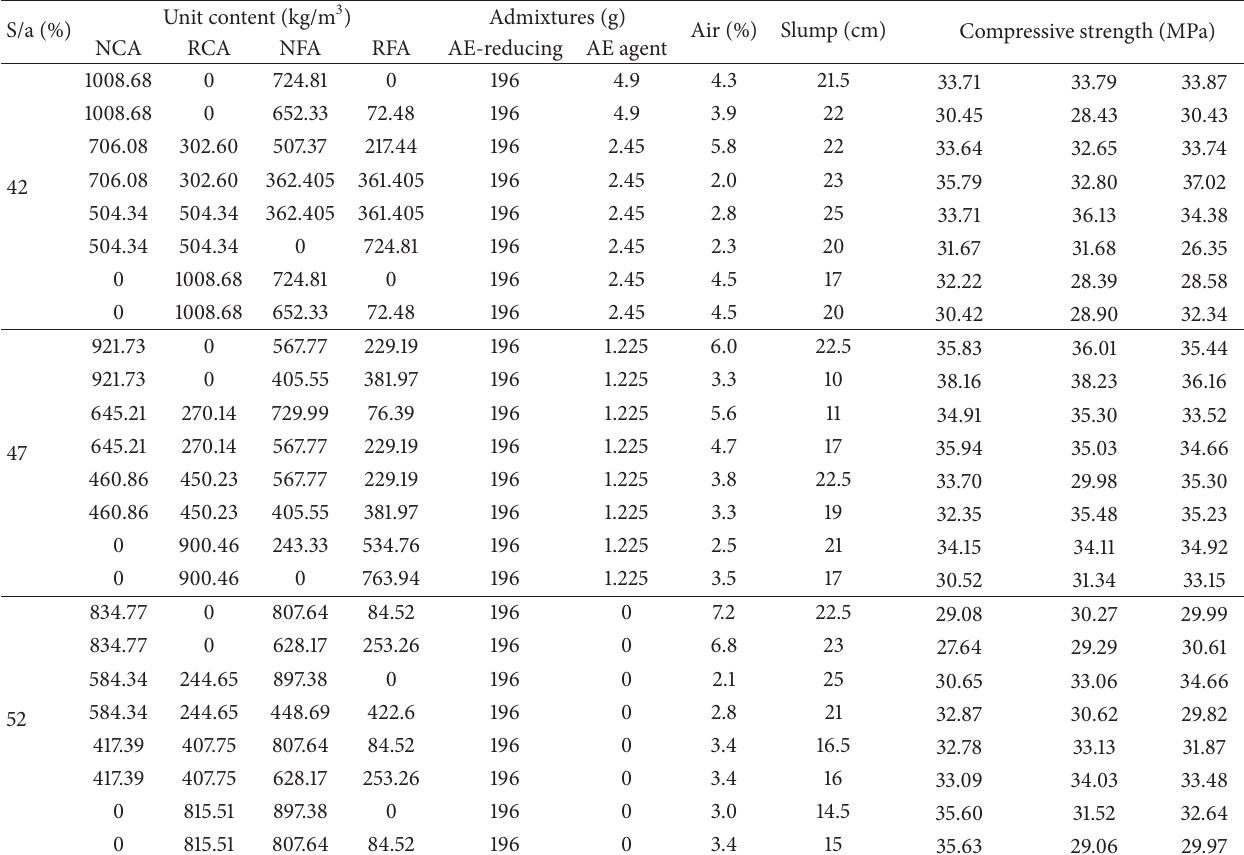
Table 2: Sample of specified concrete mixing proportions used for NN